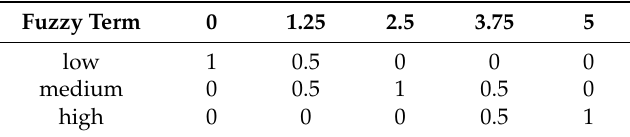
Figure 3. Degree of membership of the cutting depth.